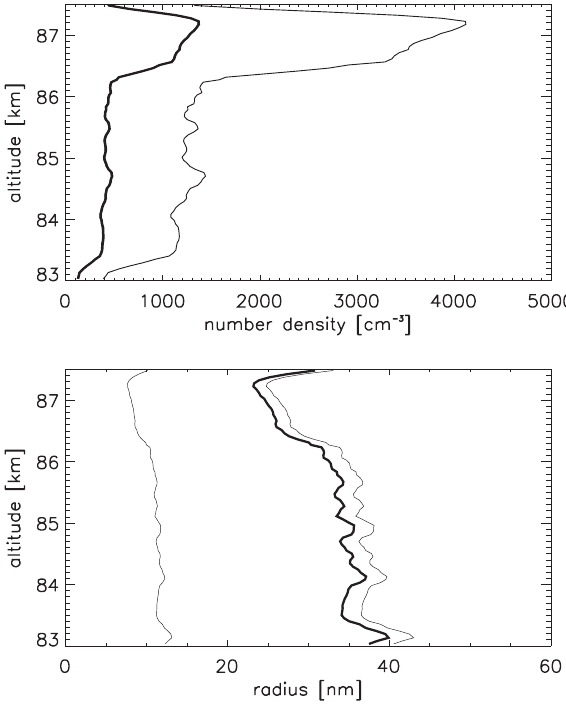
Fig. 10. Altitude profiles of ice particle number densities (assum- ing singly charged particles, upper panel, thick black line) and parti- cle radii (assuming monodisperse particles, lower panel, thick black line) with corresponding uncertainties (thin black lines). Note that the very asymmetric uncertainty of the number density is due to the fact that the Faraday Cup could severely underestimate the particle number density because only net current can be measured, whereas the error to lower values is solely determined from the statistics of our data and is of the order of 5cm − 3 . The uncertainty of the particle radii is due to the combined uncertainty of the ice volume density estimate and the number density